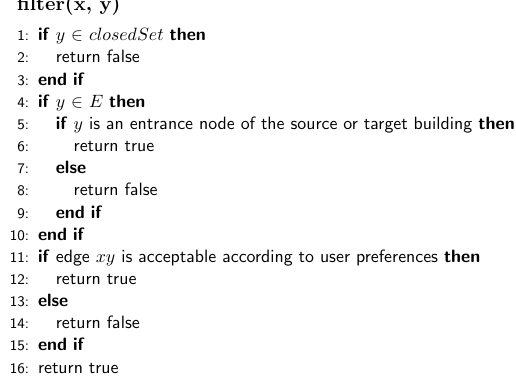
Figure 13. The function for filtering edges and